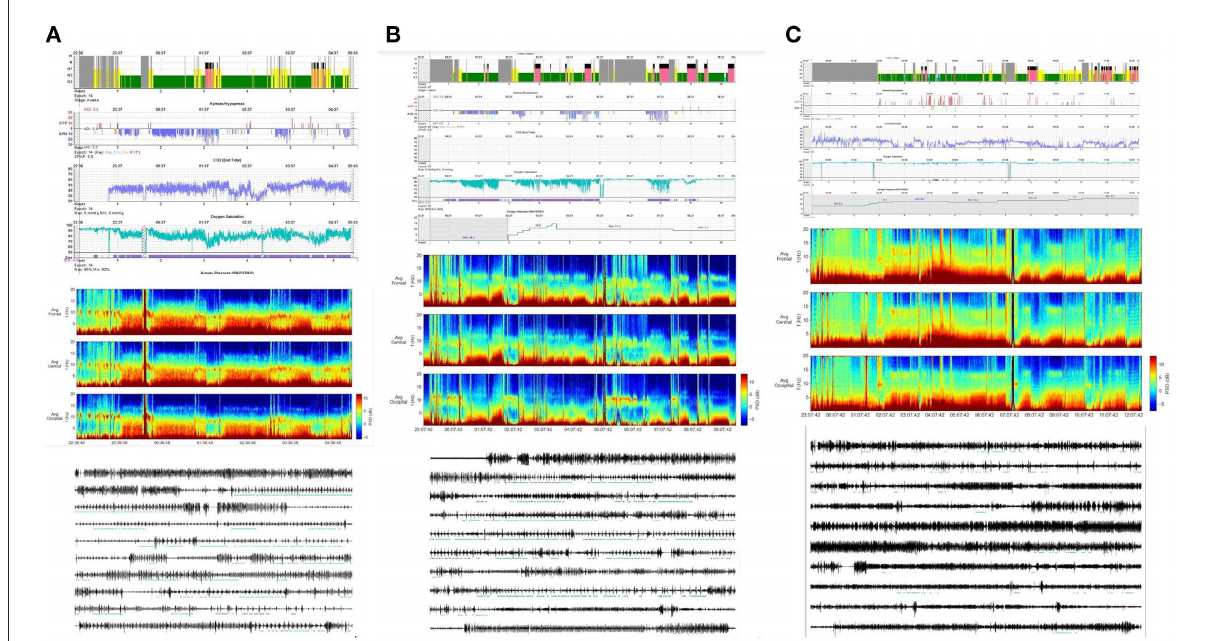
FIGURE6 Three examples showing that value of vertical integration of high-quality EEG spectral analysis inclusive of respiration, oximetry, capnometry, and respiratory phenotype in OSA patients. (A) Patient with intrinsically high sleep quality, who develops severe sleep apnea and high loop gain, complicated by hypoventilation. Merely supporting the upper airway with continuous positive airway pressure will improve oxygenation and ventilation, but respiratory instability is likely to persist. Aggressive ventilation could amplify periodic breathing. In this case, a contribution from sleep fragmentation will be minor, given the high delta power despite the highly disruptive pathology. (B) Delta power profile is highly disrupted, and initial sleep apnea treatment is not effective. Once high loop gain is targeted (oxygen and dead space), sleep and sleep apnea markedly improves. (C) Sodium oxybate is administered (3 gm) just before lights out, but the patient remains awake for over 2h. Once he falls asleep, the large increase in slow-wave power typical of oxybate sleep effects in not seen, but rather, sleep stage and sleep powers remain fragmented. Slow-wave power increases late, suggesting that there is substantial circadian phase delay. The drug does cause an increase in delta power while awake, before sleep onset. This fragmentation is contributed to by difficult to treat sleep apnea, and sleep fragility of uncertain cause. This patient has a diagnosis of hypersomnia in addition, being able to sleep 16 + h in a 24-h period. Even after the second dose of oxybate (3 grams), sleep remains fragmented. Stable breathing is relatively low, but there is no pervasive periodic breathing / high loop gain apnea as in the